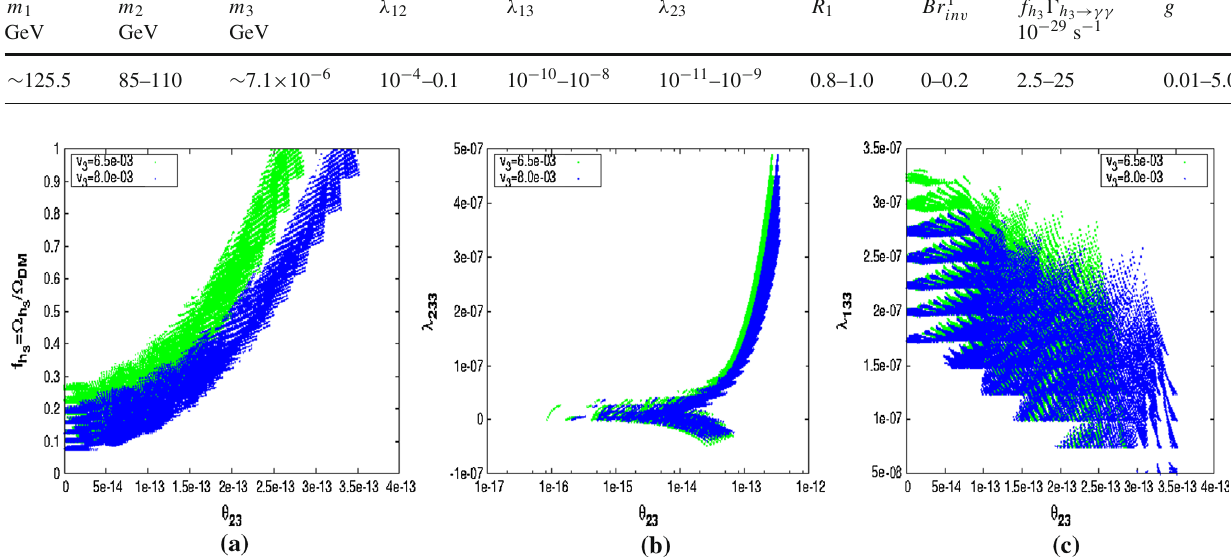
Fig. 2 The left panel (Fig. 2a) shows the changes in f h